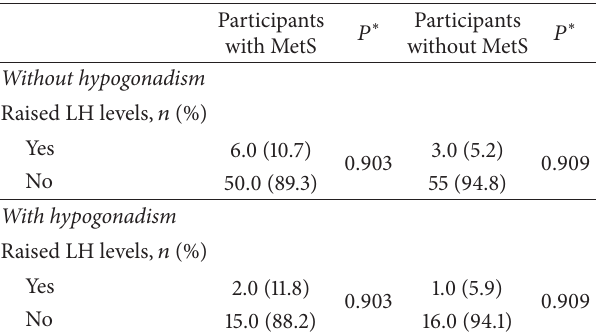
Table 2: Hypothalamic-pituitary-gonadal axis response to metabolic syndrome (MetS).